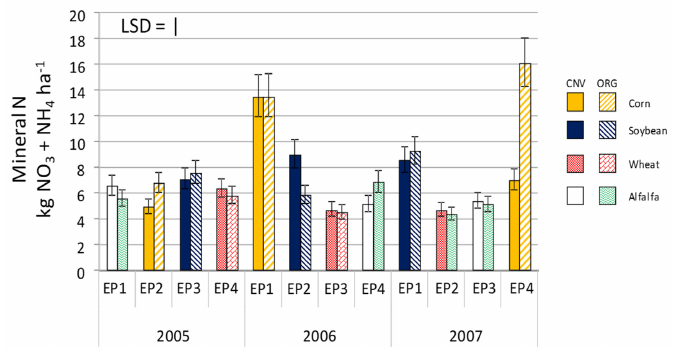
Figure 3. Average standing stocks of available soil mineral N (kg NO 3 − -N + NH 4 + -N ha − 1 ) (0–9 cm depth) for each crop by initial crop rotation entry point (EP) for conventional (CNV) and organic (ORG) management systems for the 2005 through 2007 growing seasons. Note: CNV wheat was under-seeded with alfalfa in all years; ORG wheat was under-seeded with alfalfa only in 2005, then dropped from the rotation in 2007. Bars show standard error of the mean. Least significant difference (LSD) is indicated by the dark bar in the upper left corner. Each bar represents the mean of four replicates. Crop rotation EP is defined in Figure 2.